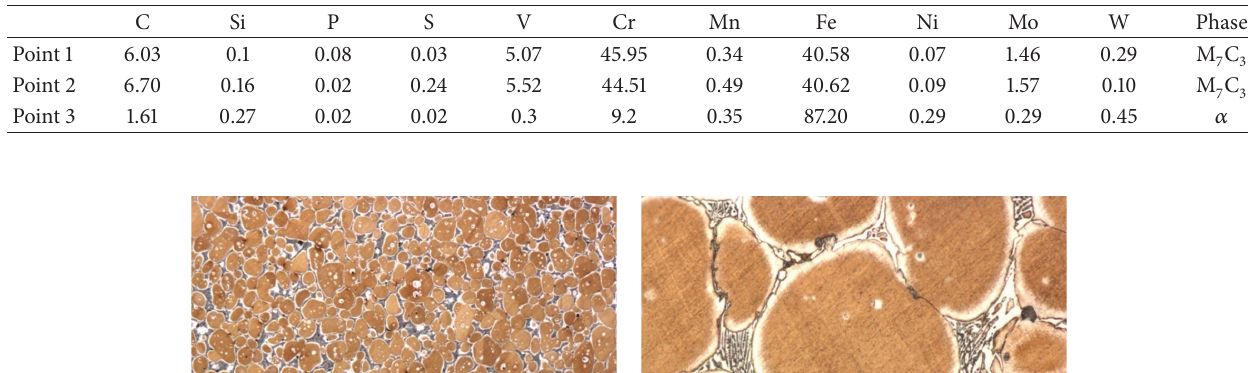
Table 2: EDX analysis results for the carbides and ferrite matrix wt.% shown in Figure 4.